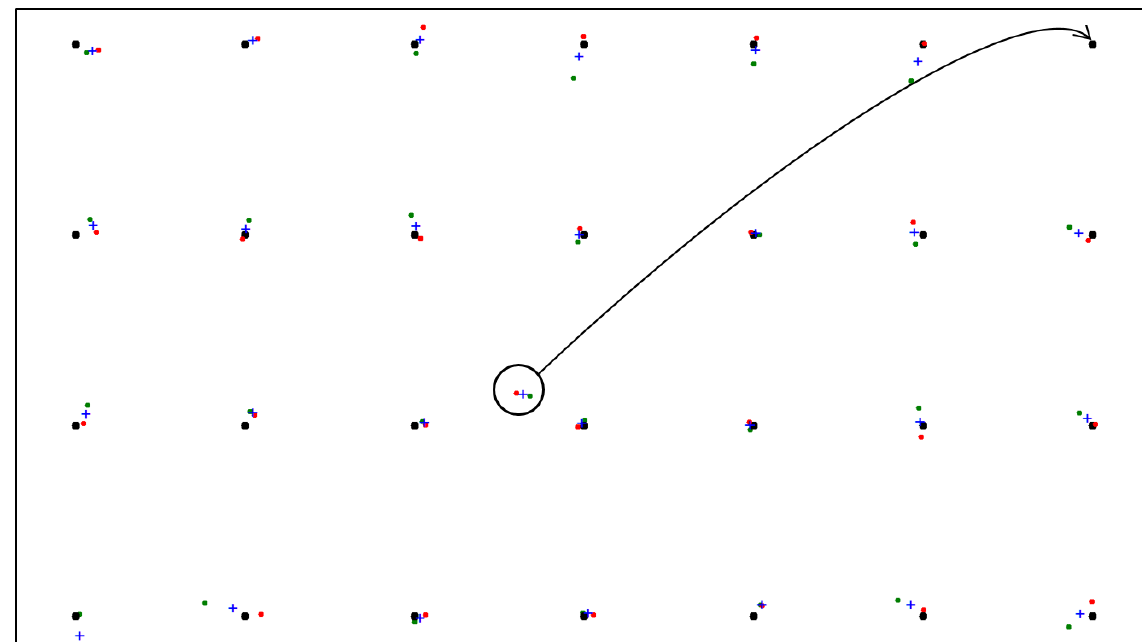
Figure 3. Validation points with left (green) and right (red) eye averages of samples per point. The average be- tween eyes is indicated with a blue + . A point where the participant was distracted, is also shown.